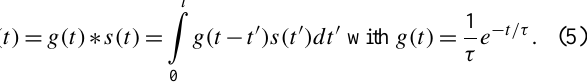
Figure 6 illustrates this deconvolution exemplarily for one flask measured in 4 August 2009. Three consecutive data points of the CRDS analyzer are combined to one (repre- senting 1.5 min, grey dots) and give the basis for a smoothed spline (grey line, degrees of freedom is 2/3 of the length of the data series), representing c(t) . Equation (6) gives the ap- proximate in-situ data (red line). For our attempt to estimate the errors (red dashed line) we used the standard deviation of the three combined CRDS data points (light grey bars) scaled √ (cid:14) √ τ τ 0 that accounts for the deconvolution with the factor